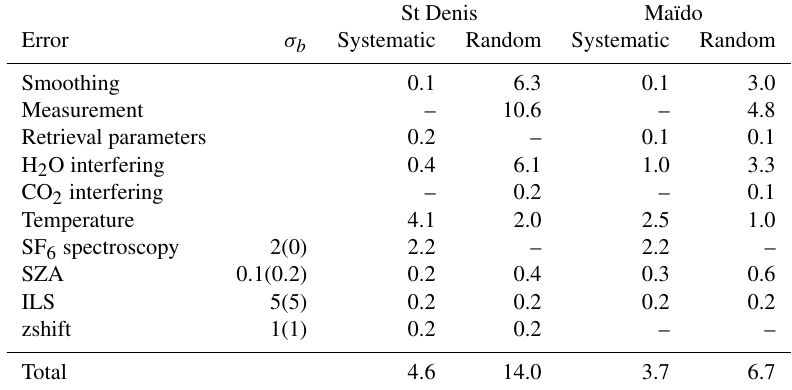
Table 2. The systematic and random uncertainties for the FTIR-retrieved total column (%) at St Denis and Maïdo. σ b are the relative systematic (random) uncertainties of the non-retrieved parameters (%). The “retrieval parameters” represents the “others” in Eq. (3). The SF 6 spectroscopy uncertainty is from the pseudo-line database. When a relative uncertainty is smaller than 0.1%, it is considered negligible and represented as “–”. St Denis Maïdo Error σ b Systematic Random Systematic Random